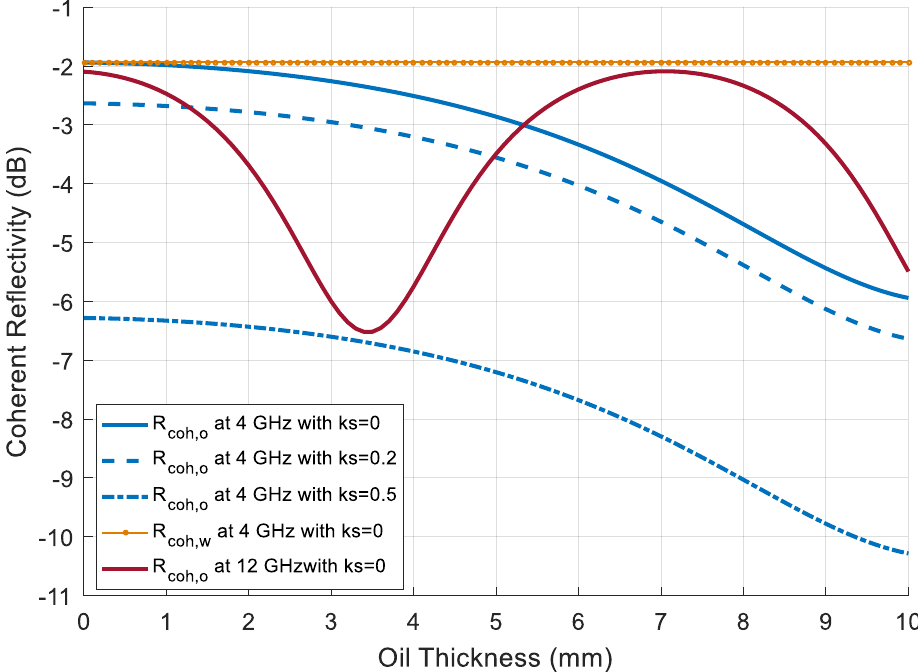
Figure 2. Comparison between the reflectivity values (in dB) versus the oil thickness (in mm) at 4 GHz and 12 GHz for different roughness scenarios. R o and R w in each graph represents the oil and water reflectivity values,